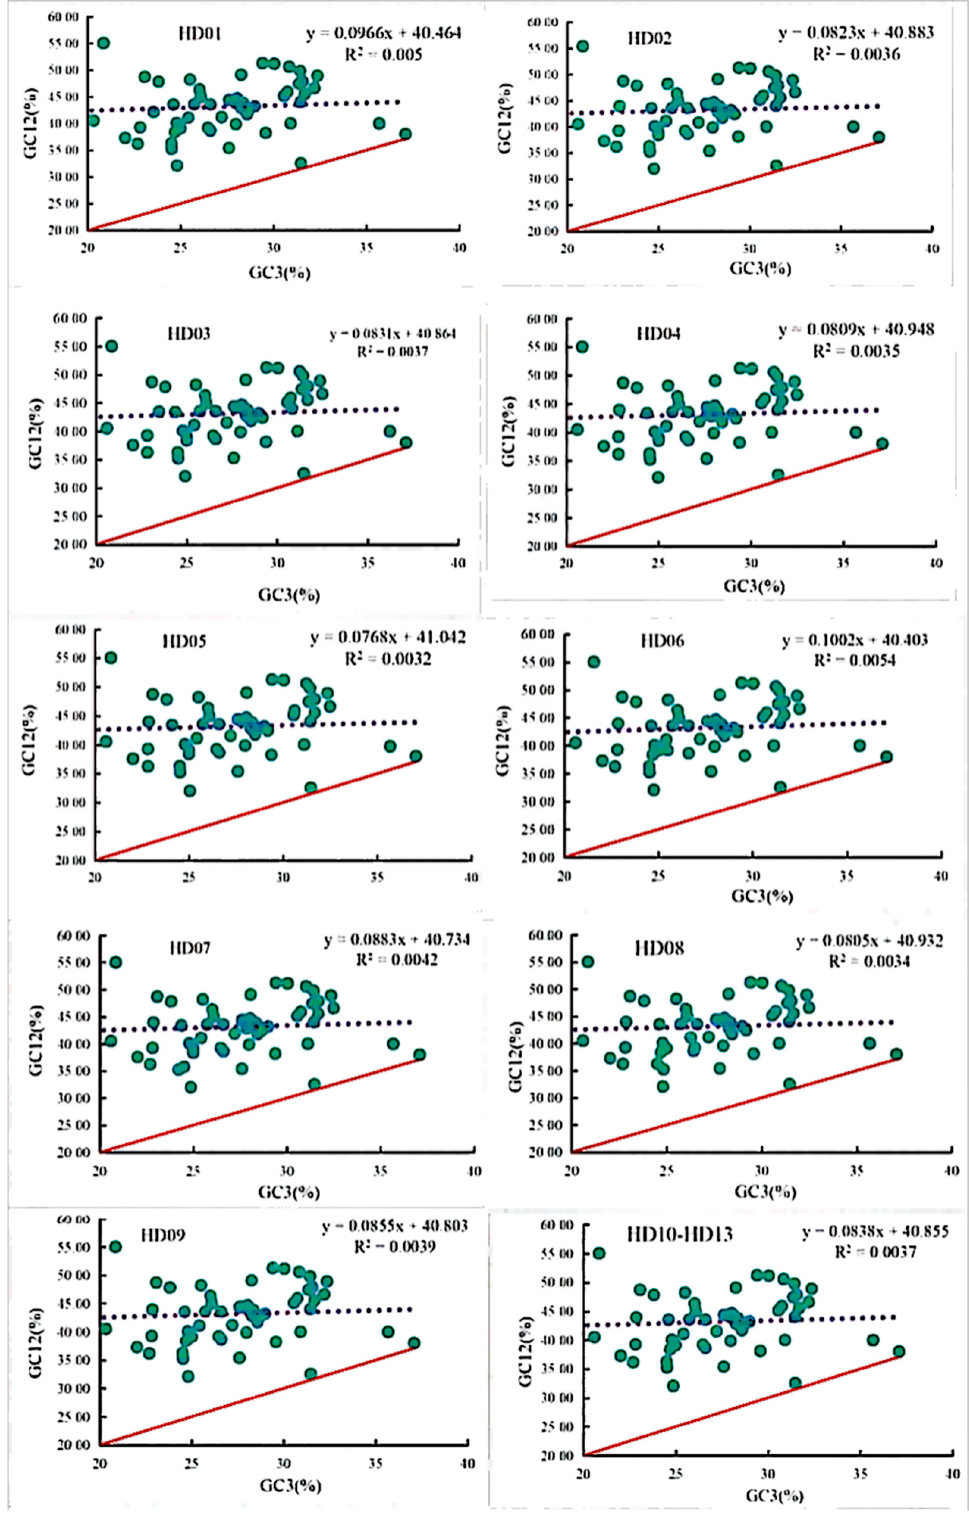
Figure 3. Neutrality plot analysis of codons in the chloroplast genomes of oil-tea camellia.